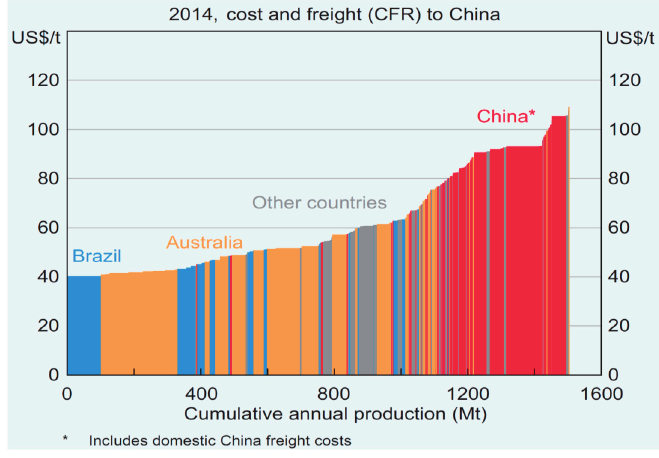
Figure 8. Global iron ore production costs, including freight to China, 2014